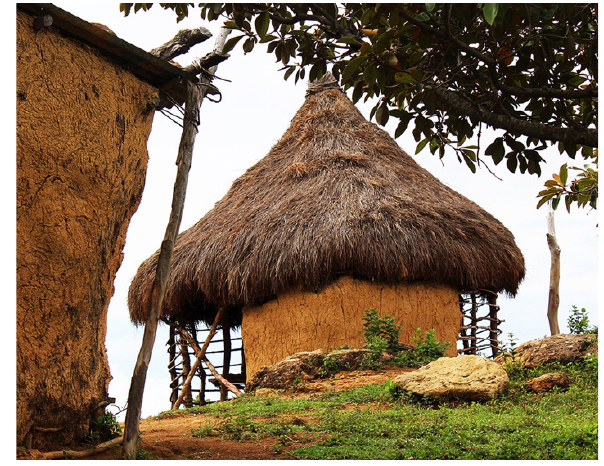
Figure 18. Buglé house at Batata.